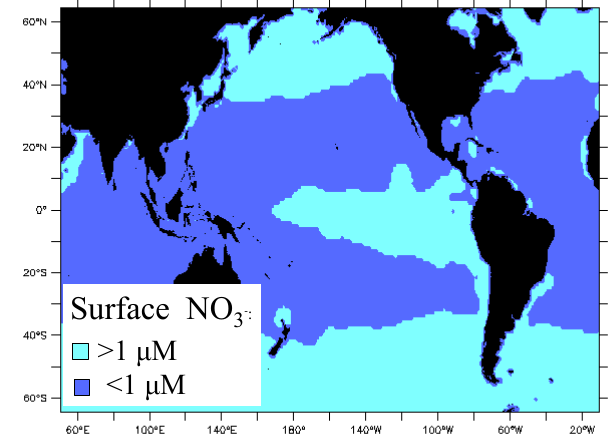
Fig. A2. Regions of the Pacific and surrounding regions where sur- face nitrate (NO − ) concentrations are above and below 1µM. Based 3 on annual 1-degree World Ocean Atlas 2009 data (Garcia et al.,